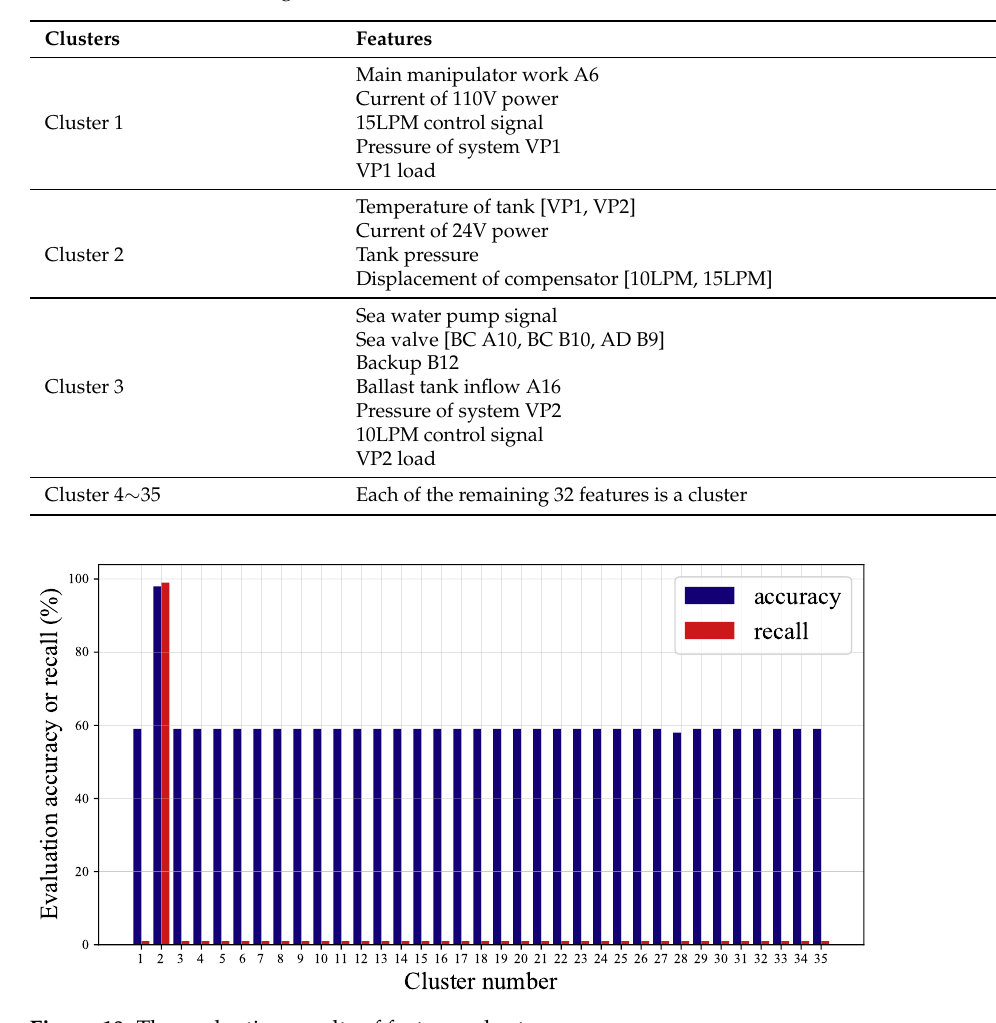
Table 3. Feature clustering results.